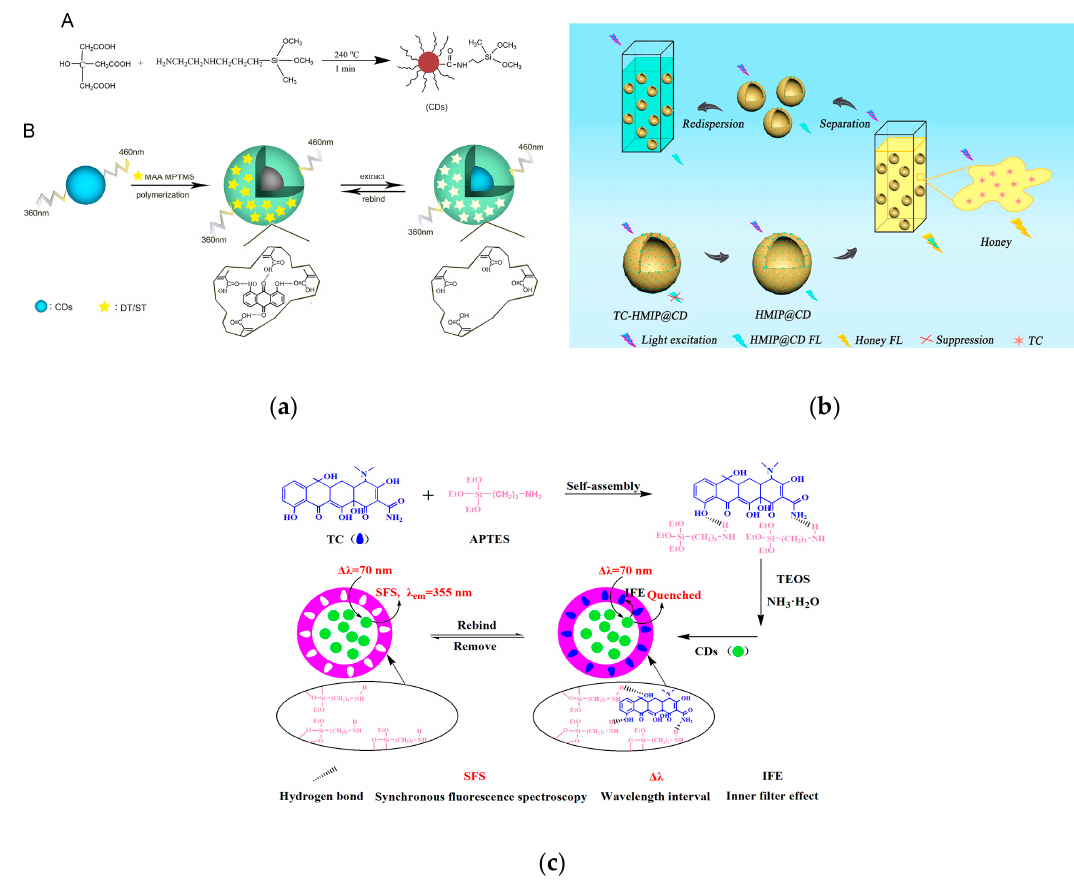
Figure 9. Application of MIP@CD sensor in fluorescence detection. ( a ) Scheme of preparation